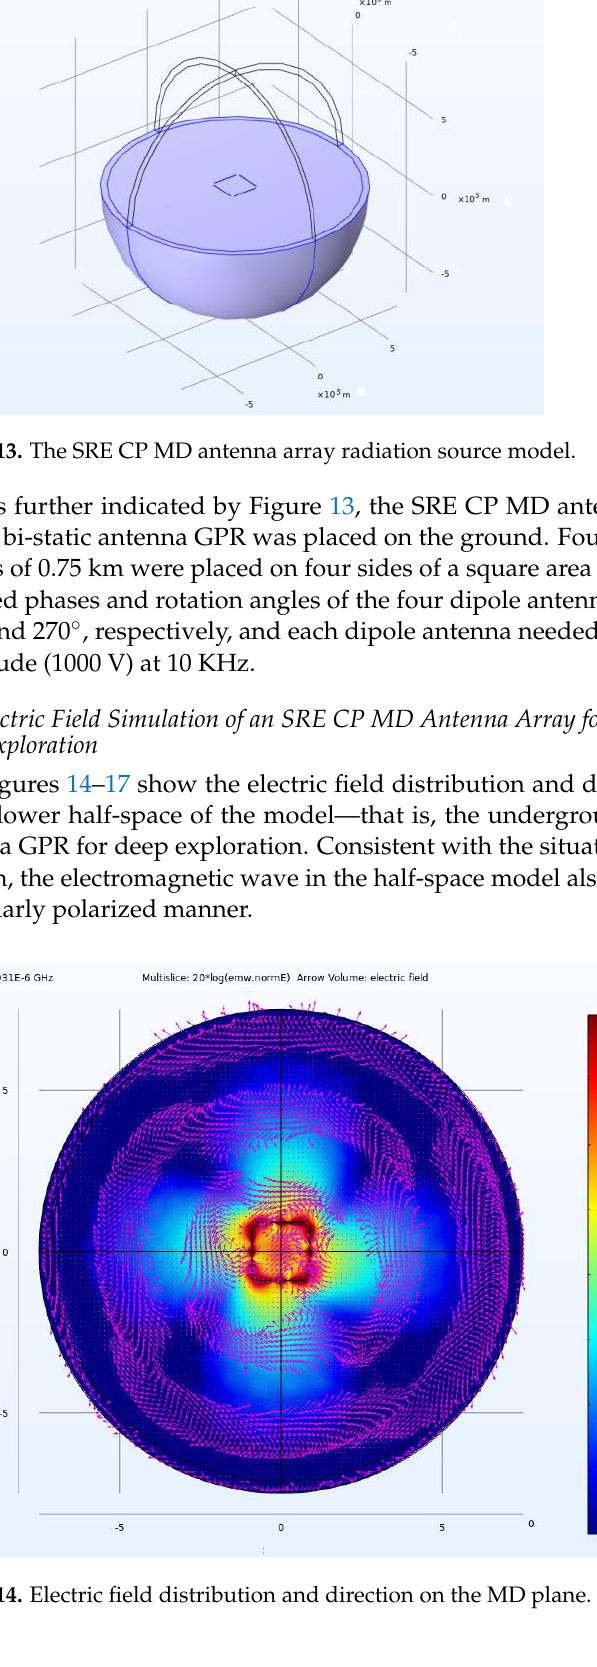
Figure 14. Electric field distribution and direction on the MD plane.